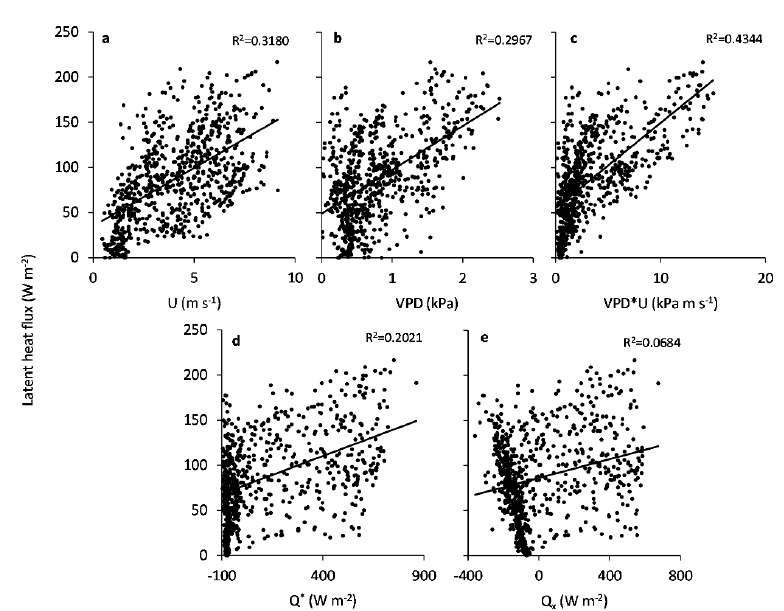
Figure 6. Relationship between latent flux and wind speed ( U ) ( a ), vapor pressure deficit ( VPD ) ( b ), product of VPD multiplied by wind speed ( VPD ∗ U ) ( c ), net radiation ( Q ∗ ) ( d ), and water heat flux ( Q x ) ( e ).